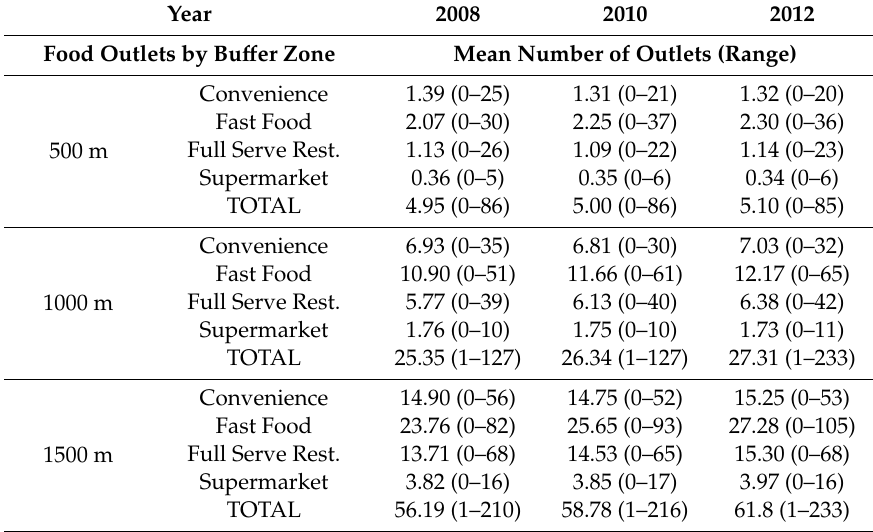
Table 4. Food retail outlets within 500, 1000 and 1500 m of all regional